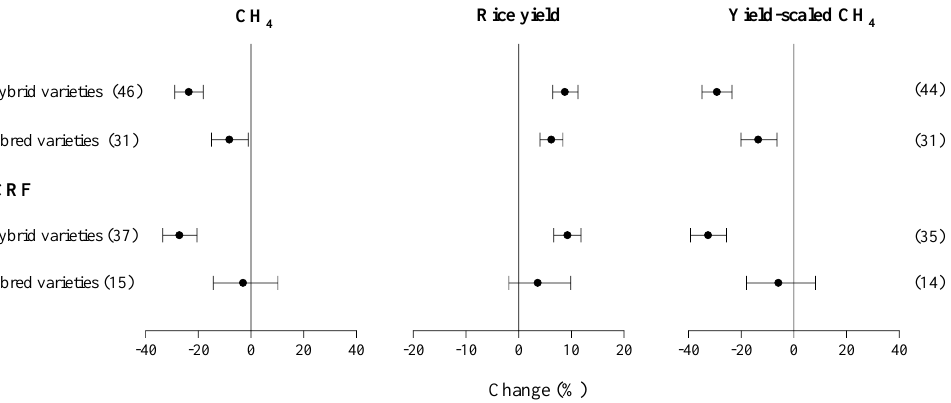
Figure 3. Impacts of rice variety on the efficacy of IS and S/CRF on CH 4 , rice yield, and yield-scaled CH 4 emission from rice fields.